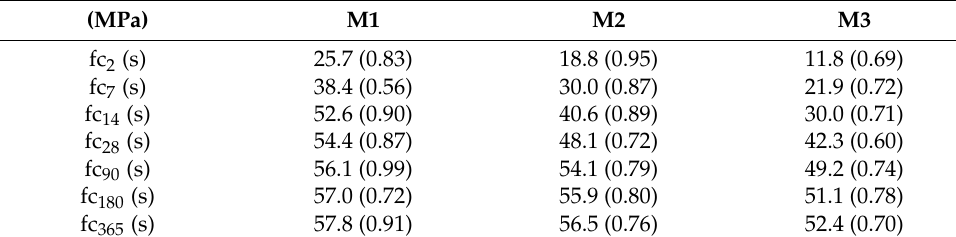
Table 5. Compressive strength (MPa) and standard deviation of mortar mixtures.